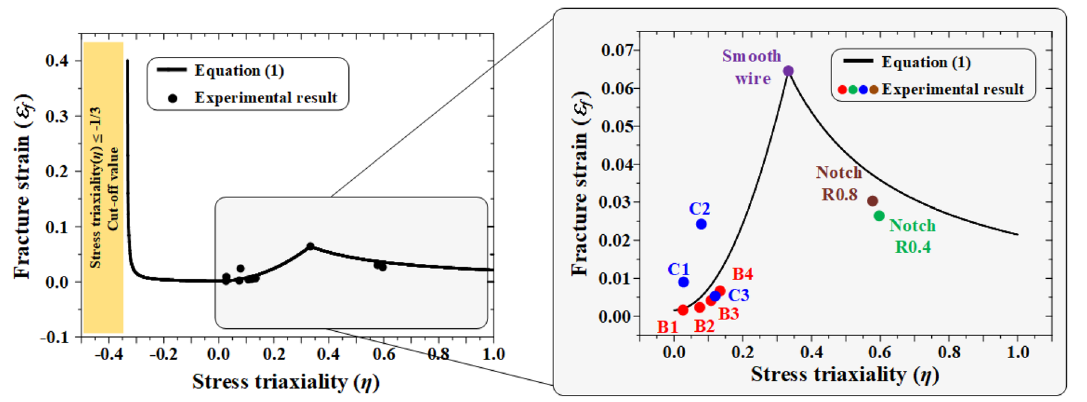
Figure 4. Fracture strain as a function of stress